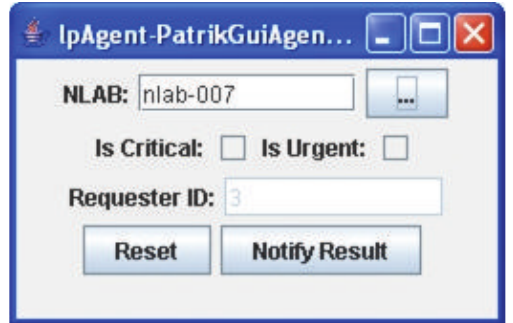
Figure 3: Patrik’s laboratory personnel agent